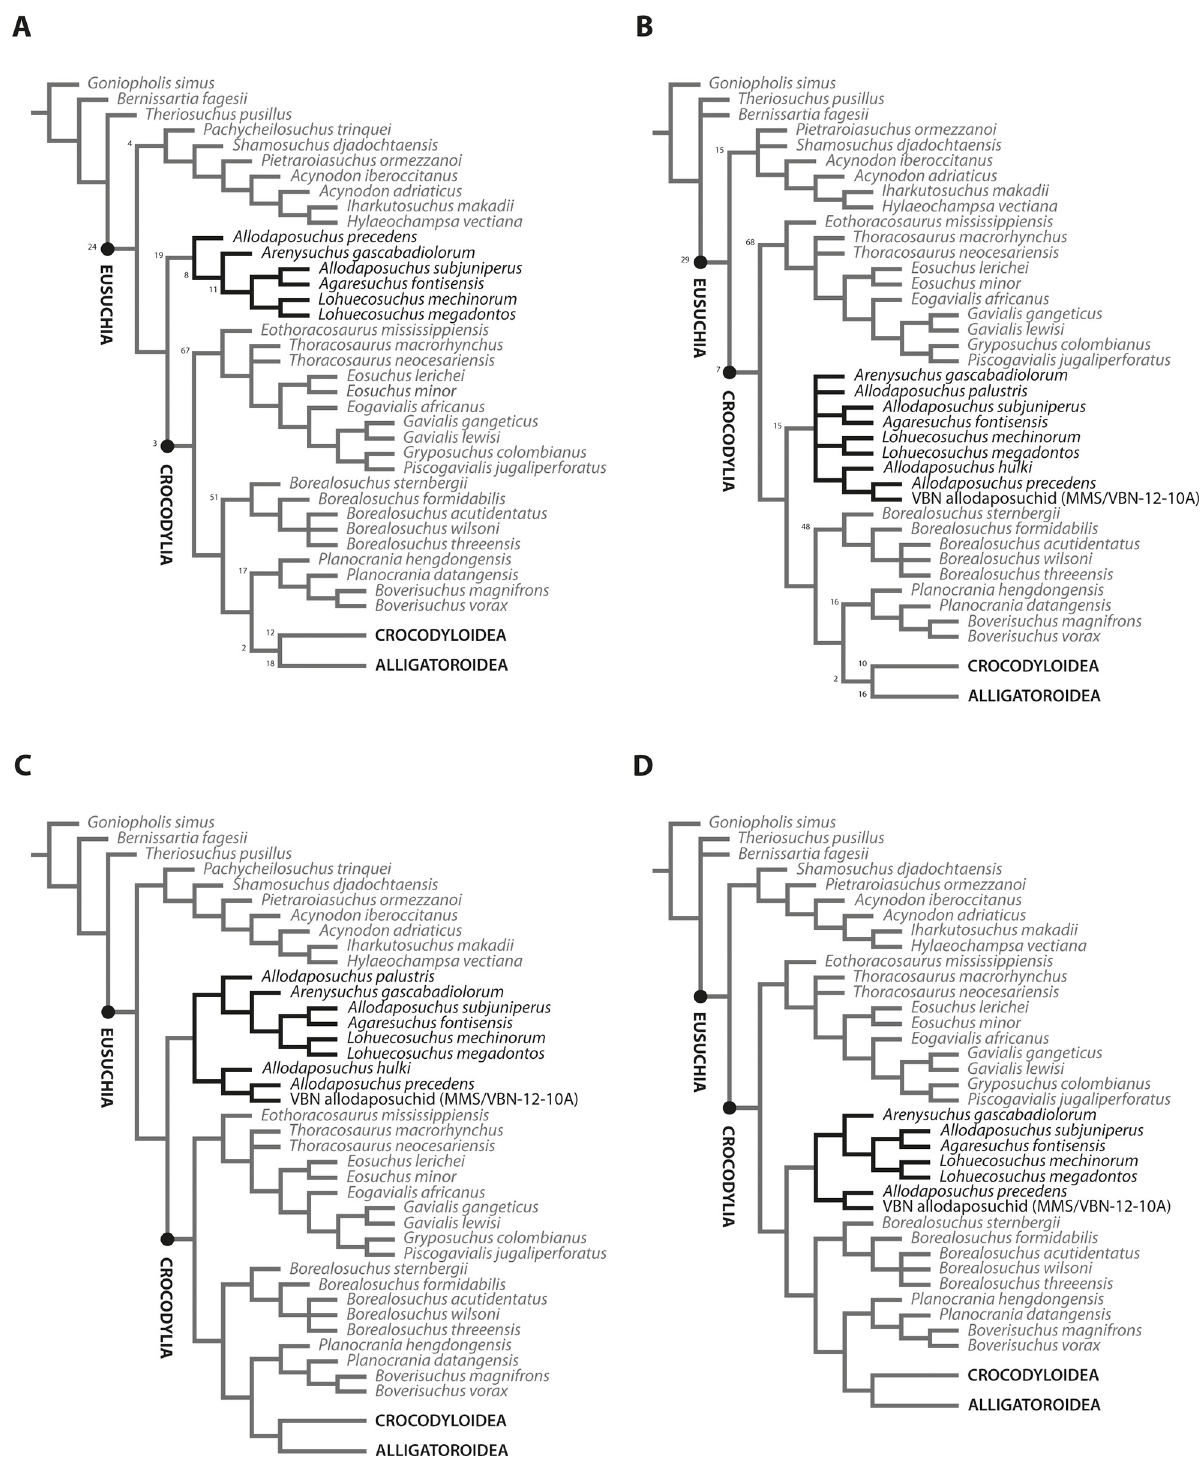
Fig 3. Comparison between phylogenetic analyses including and lacking postcranial information: A) reproduction of the analysis of Narva´ez et al. [12]; B) addition of A . palustris and A . hulki with postcranial information to the dataset of Narva´ez et al. [12]; C) topology from replicated phylogenetic analysis excluding postcranial information in allodaposuchid taxa; and D) topology from phylogenetic analysis including postcranial information, but lacking A . palustris and A . hulki as OTUs. Numbers indicate bootstrap support for the main nodes.